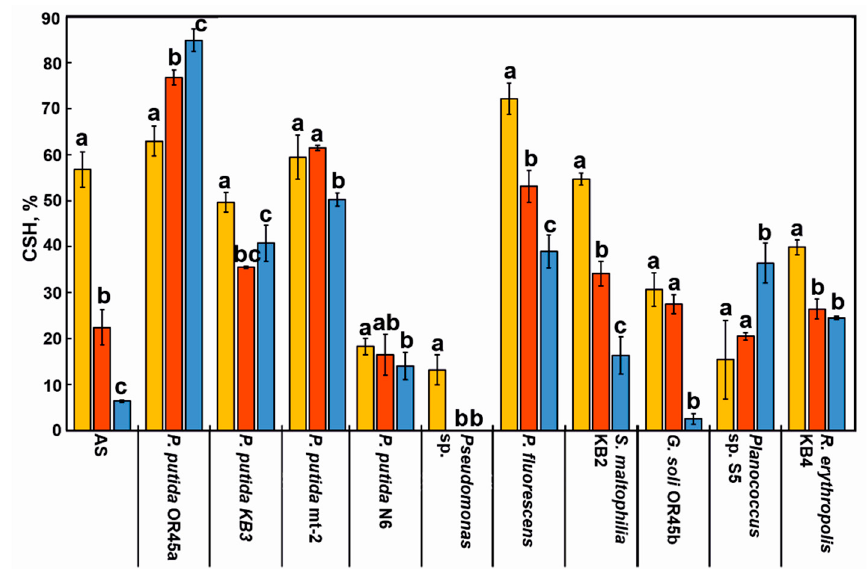
Figure 4. Effect of the KPL on the cell surface hydrophobicity (CSH) of the tested bacterial strains and the overall hydrophobicity of microorganisms derived from the AS.